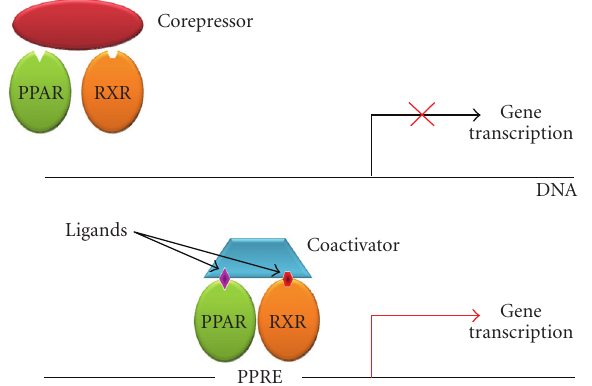
Figure 1: Mechanism of PPAR γ activation. Upon ligand binding to the PPAR/RXR heterodimer, a conformational change leads to release of a corepressor and binding of a coactivator; this regulates the kinetics of the assembly of the transcription complex, resulting in increased a ffi nity for the specific PPAR response element, which modulates gene transcription. RXR; Retinoic X receptor; PPRE; PPAR response